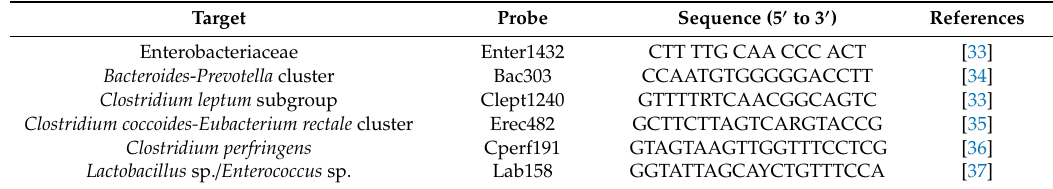
Table 2. Oligonucleotide